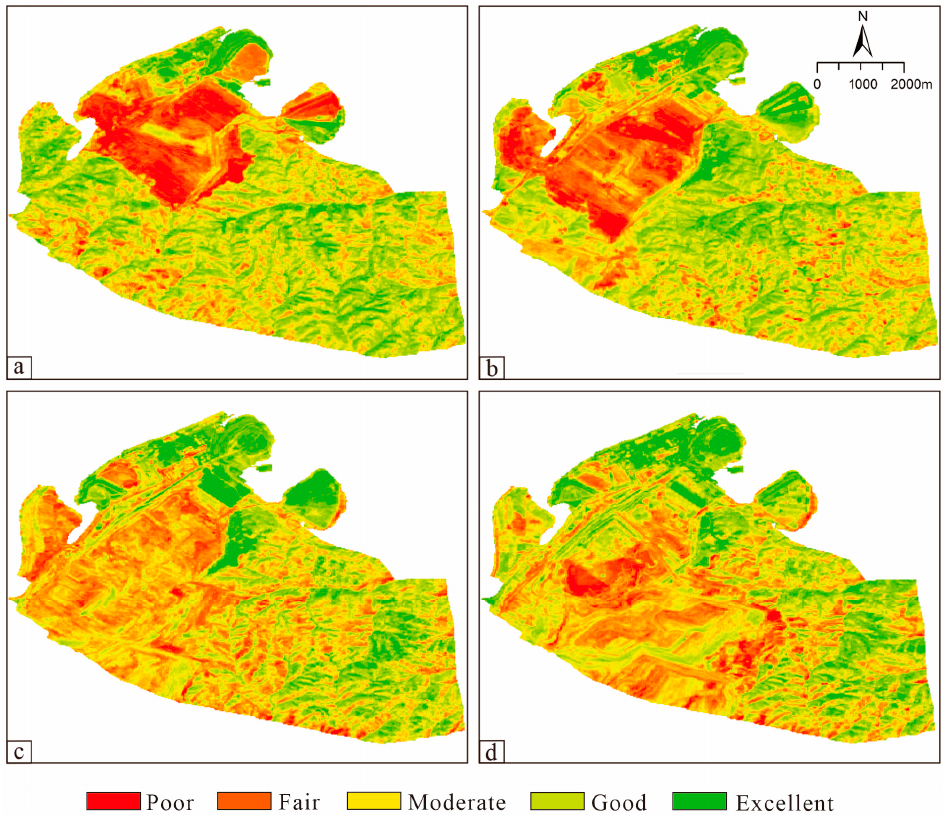
Figure 10. Distribution of RSEI grades at different periods in the mining area. ( a ) 2006, ( b ) 2011, ( c ) 2016, ( d ) 2021. Table 7. Area and percentage change of each RSEI level in different years.